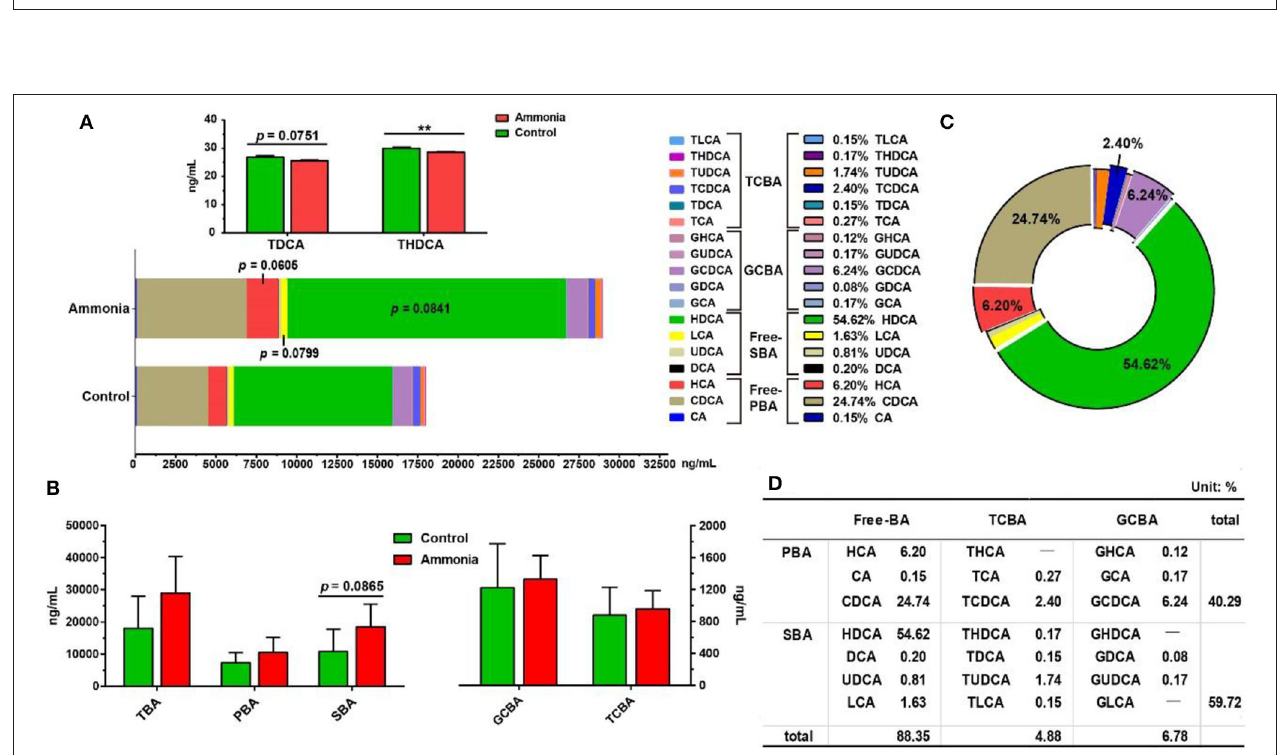
FIGURE 1 | The level of serum metabolites after atmospheric ammonia exposure. The contents of serum leptin and adiponectin after high ammonia exposure. (A) The level of ALT and AST in serum after high ammonia exposure. (B) The alteration of HDL-C, LDL-C, and VLDL in serum after ammonia exposure. (C) Data are expressed as min to max showing all points ( n = 6), # p < 0.1 and ** p < 0.01.